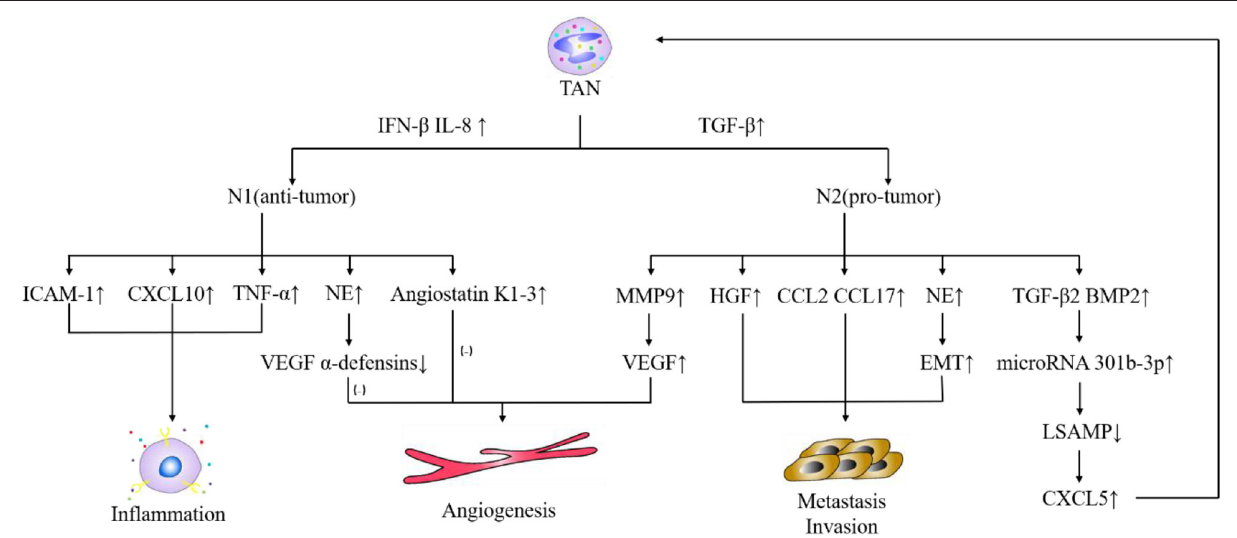
FIGURE 1 | Dual roles of TAN in HCC. IFN- β , interferon- β ; IL-8, interleukin-8; TGF- β , transforming growth factor- β ; ICAM-1, intercellular cell adhesion molecule-1; CXCL, chemokine (C-X-C motif) ligand; TNF- α , tumor necrosis factor- α ; NE, neutrophil elastase; VEGF, vascular endothelial growth factor; MMP9, matrix metalloproteinase 9; HGF, hepatocyte growth factor; CCL, chemokine (C-C motif) ligand; EMT, Epithelial-Mesenchymal Transitions; BMP2, bone morphogenetic protein 2; LSAMP, limbal gene expression membrane protein. TAN plays a critical role in pro-tumor and anti-tumor in HCC. Under the action of TGF- β (127), TAN differentiates into N2 phenotype, which promotes tumor development; while under the condition of IFN- β (128) and IL-8 (129), TAN differentiates into N1 phenotype, which limits tumor progression. N2 secretes MMP9, VEGF (128) to promote tumor angiogenesis; secretes HGF (130), CCL2, CCL17 (131), NE (132) to promote tumor metastasis and infiltration; secretes TGF- β 2, BMP2 to promote the production of microRNA 301b-3p, inhibits the production of LSAMP, promotes the production of CXCL5. CXCL5 recruits more TAN (133). N1 secretes ICAM-1, CXCL10, TNF- α (124, 134) to promote inflammation. At this time, NE secreted by N1 will degrade VEGF α -defensins collaborating with Angiostatin K1-3 (123) secreted by N1 to inhibit angiogenesis and inhibit tumor progression.